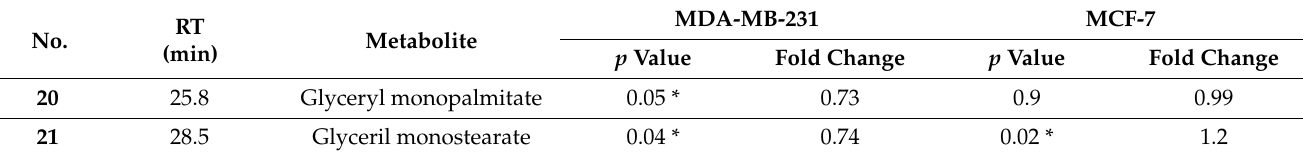
Figure 7. PCA of metabolic profile of MDA-MB-231 and MCF-7 cells. Notes: PCA of metabolic profile of MDA-MB-231 ( A ) and MCF-7 cell lines ( B ) after treatment with compound 1 in duration of 48 h. PCA, principal component analysis.